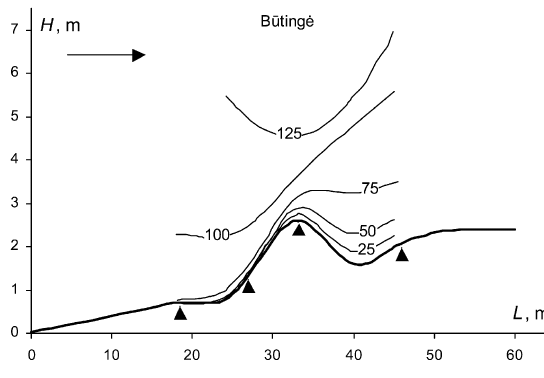
Fig. 3. Variations in wind speed (%) in the cross-shore profile near B ū ting ė . In Figs 3(cid:150)8: H (cid:150) height (m) above sea level, L (cid:150) distance (m) from the coastline, wind direction is marked by arrows, wind speed measuring sites are denoted by small triangles, numbers on lines show per cent of wind speed, where a 100% isovel corresponds to wind velocity in the middle point of the beach, at a height of 2 m above the ground surface.